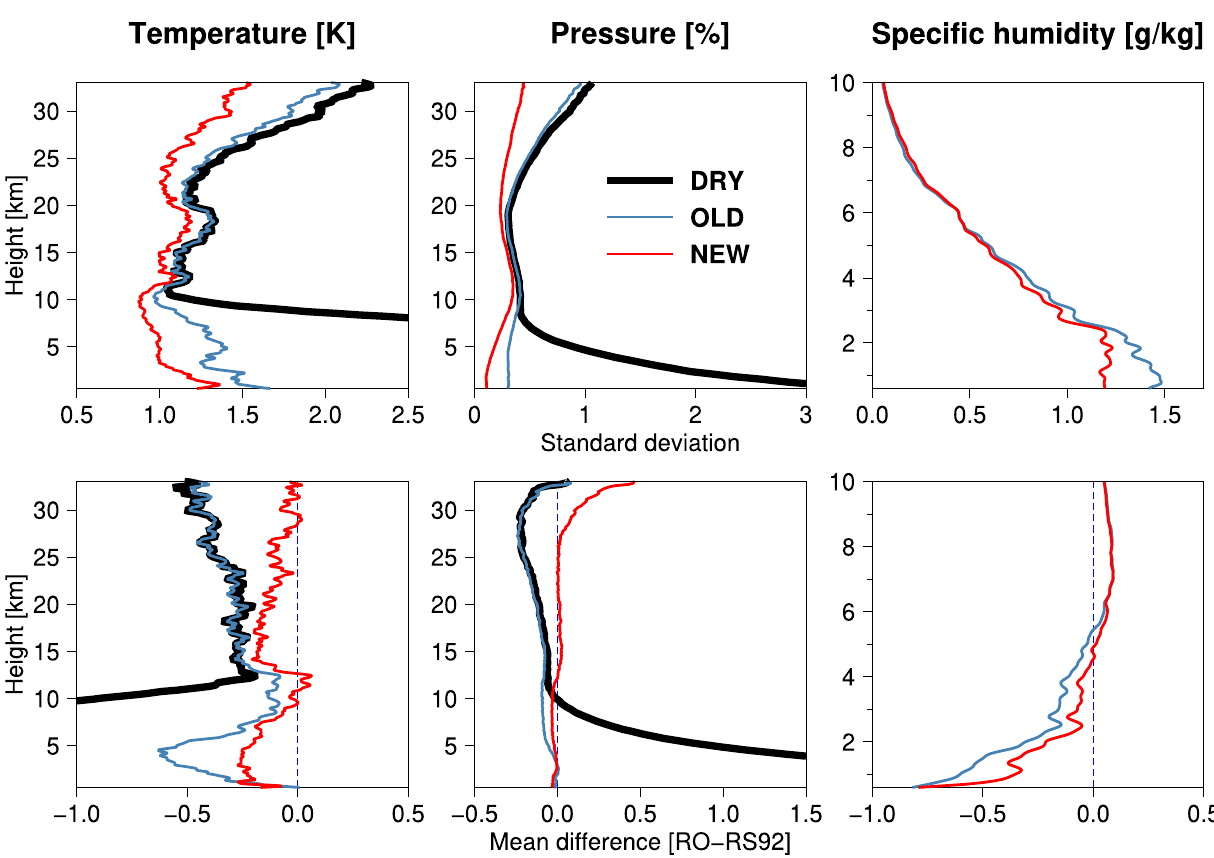
Figure 14. COSMIC retrievals compared to collocated high vertical resolution RS92 observations in temperature ( left panels ; °C), pressure ( middle ; %), and specific humidity ( right ; g kg −1 ) for the period from May 2006 to August 2015. Upper panels are standard deviations and lower panels are mean differences.